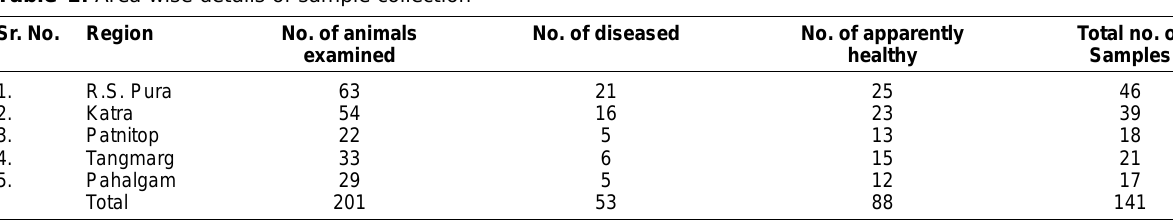
Table-2. Bacterial species isolated from the upper respiratory tract of equines Sr.